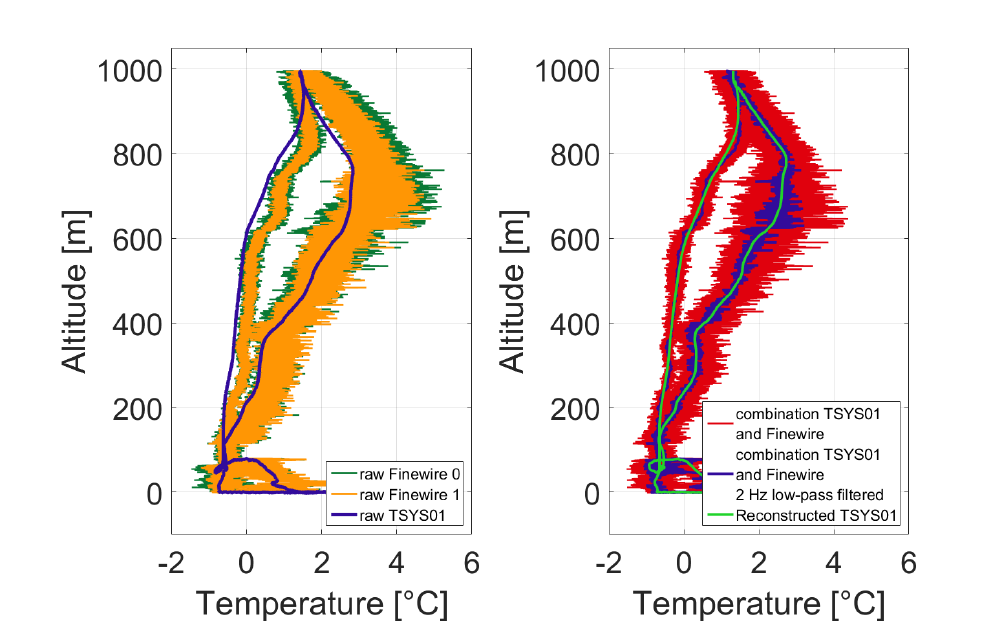
Figure 5. ( Left ): ALICE raw profiles of temperature obtained with different sensors on 1 October 2017: Two fine-wire sensors (green and orange) with fast response time, and the digital TSYS01 sensor (blue) with slow response time. Descent is the line with higher fluctuations. ( Right ): ALICE profiles of processed temperature data: Combination of the high-pass filtered signal of the fast fine-wire “Finewire 0” and the low-pass filtered signal of the slow TSYS01 sensor (red), same combined signal but smoothed with a 2Hz low-pass filter (blue), and reconstructed signal of the slow sensor TSYS01 after applying the methods shown in Figure 6 (green). “Finewire 1” is not used for the processing here, but shows that the features are reproducible.